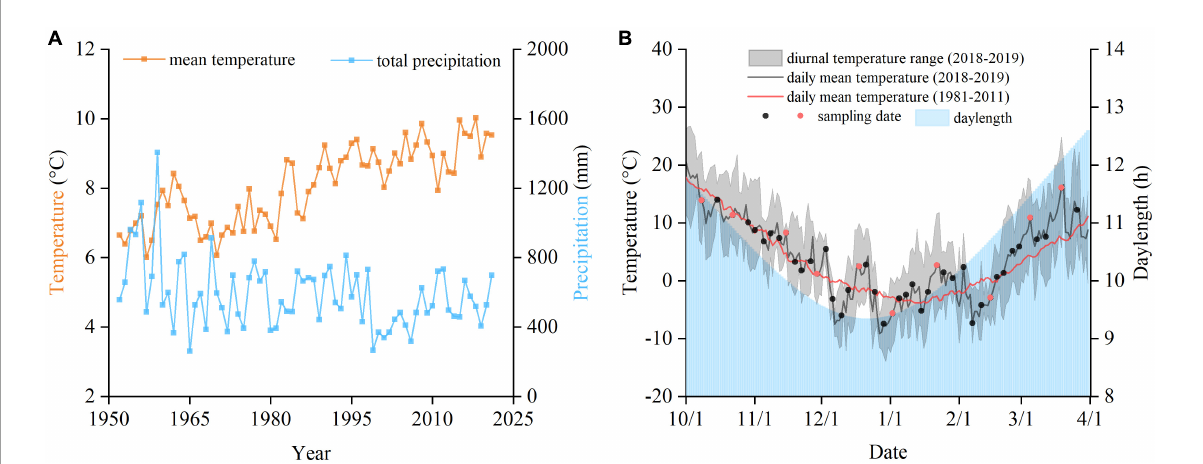
FIGURE1 Meteorological data for autumn–winter–spring (September to May) of the study area. (A) Mean temperature and annual total precipitation from 1952 to 2021. (B) Temperature and daylength during the experimental period, and sampling dates for measurement of dormancy depth (black circles) and for measurement of both dormancy depth and cold hardiness (red circles).